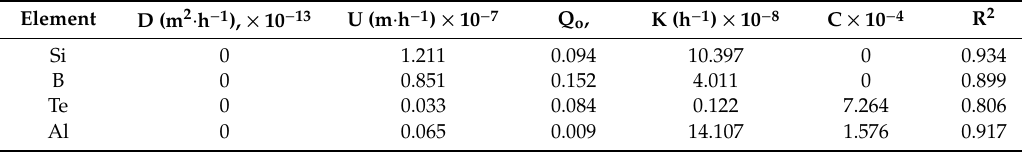
Table 10. Nonlinear curve fitting parameters of the cumulative leach fraction of metalloid and post-transition elements: MABS-Waste (20).